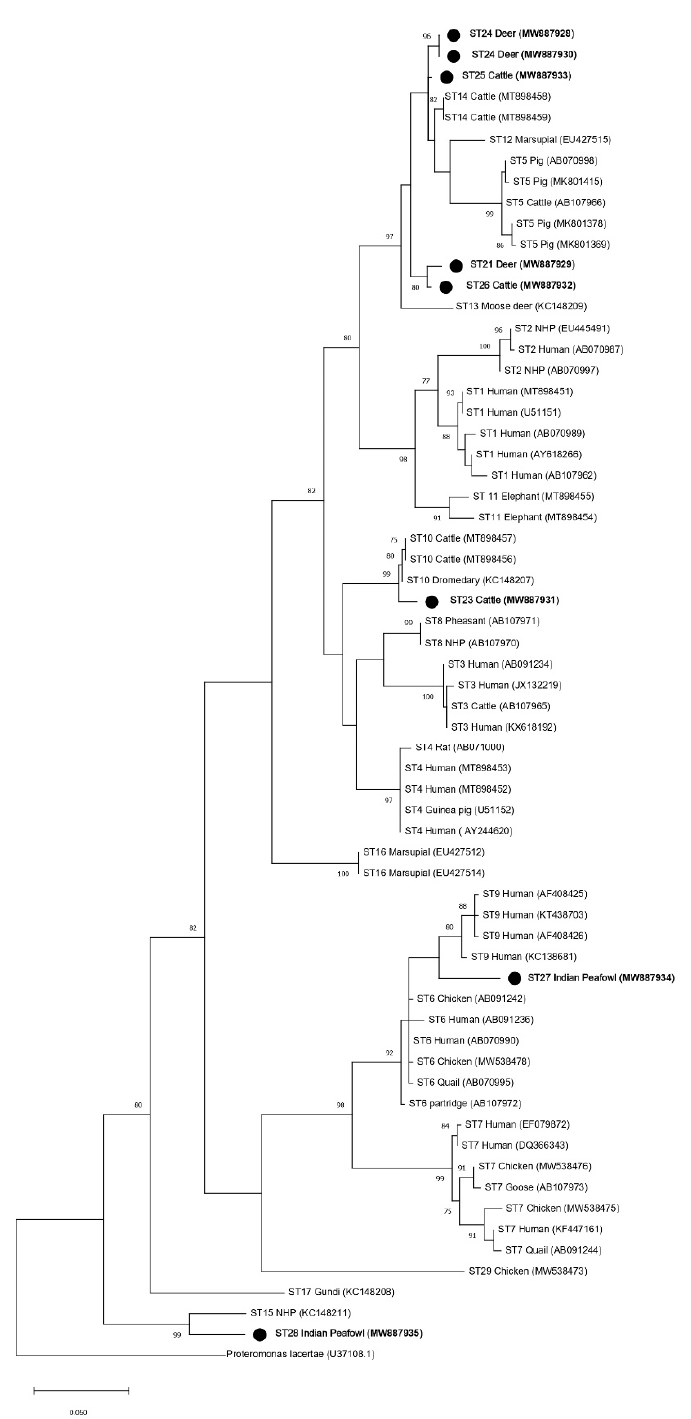
Figure 4. Phylogenetic relationships among Blastocystis partial SSU rRNA gene sequences of the barcoding region generated in the present study (represented with a black filled circle) and representative reference sequences of the accepted subtypes (Table 2). Proteromonas lacertae was used as outgroup taxon to root the tree. Analysis was conducted by a maximum likelihood method. Genetic distances were calculated using the Kimura two-parameter model. This analysis involved 64 nucleotide sequences, and there were a total of 587 positions in the final dataset. Bootstrap values lower than 75% are not displayed.